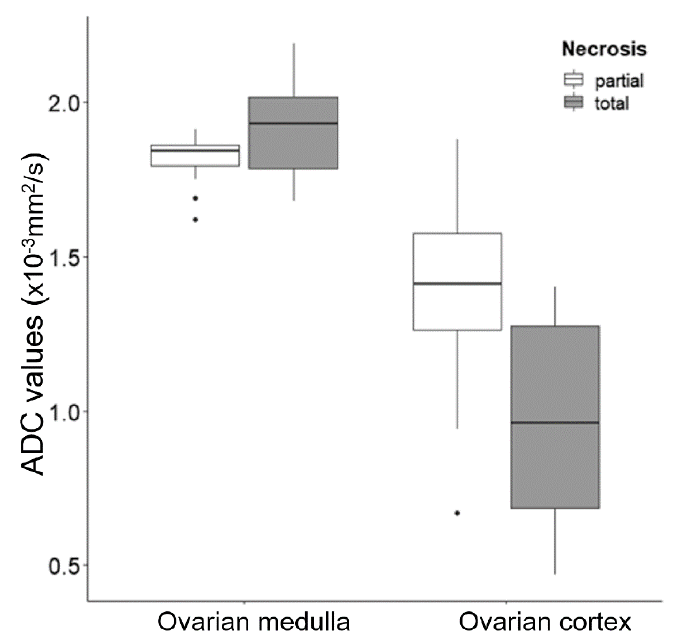
Figure 4. Box-and-whisker plot of ADC values for partial and total necrosis between ovarian medulla and cortex, respectively. The difference in ovarian cortex groups was significant. ( P = 0.022). ADC, apparent diffusion coefficient. * Data are given as mean ± SD (range).